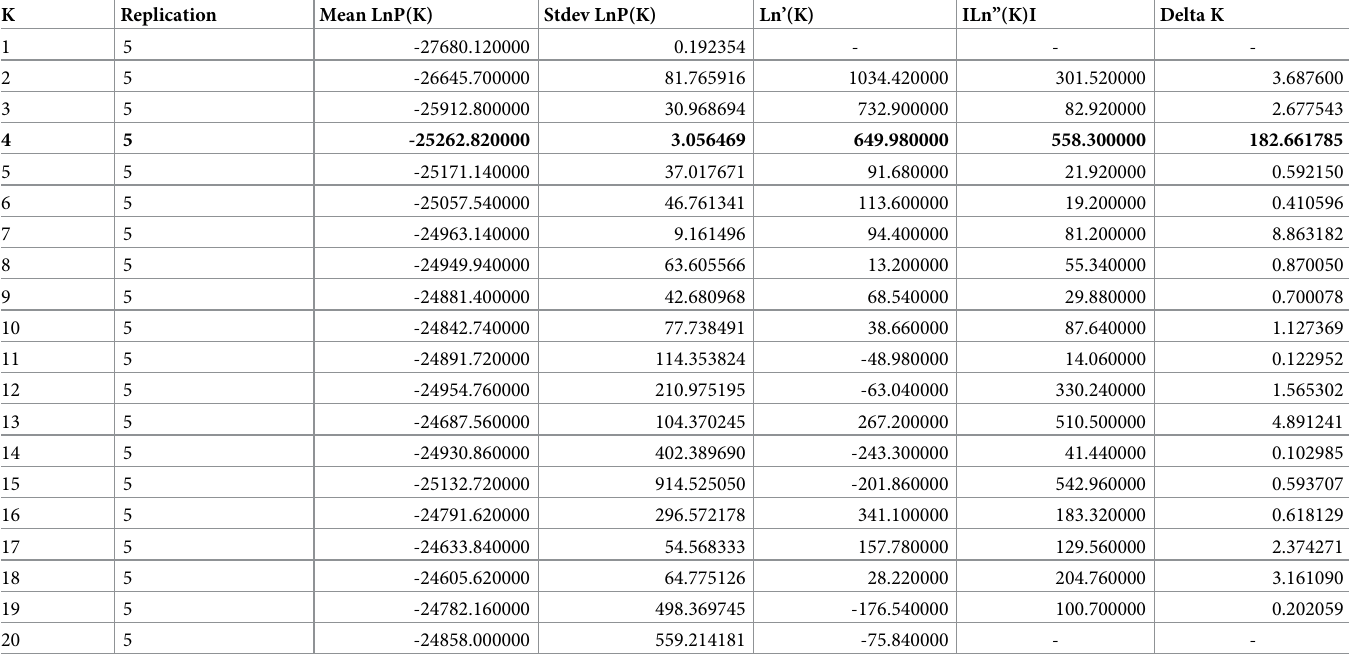
Table 8. Number of clusters (K) based on the progression of the average estimate of Ln likelihood of data in IC populations in